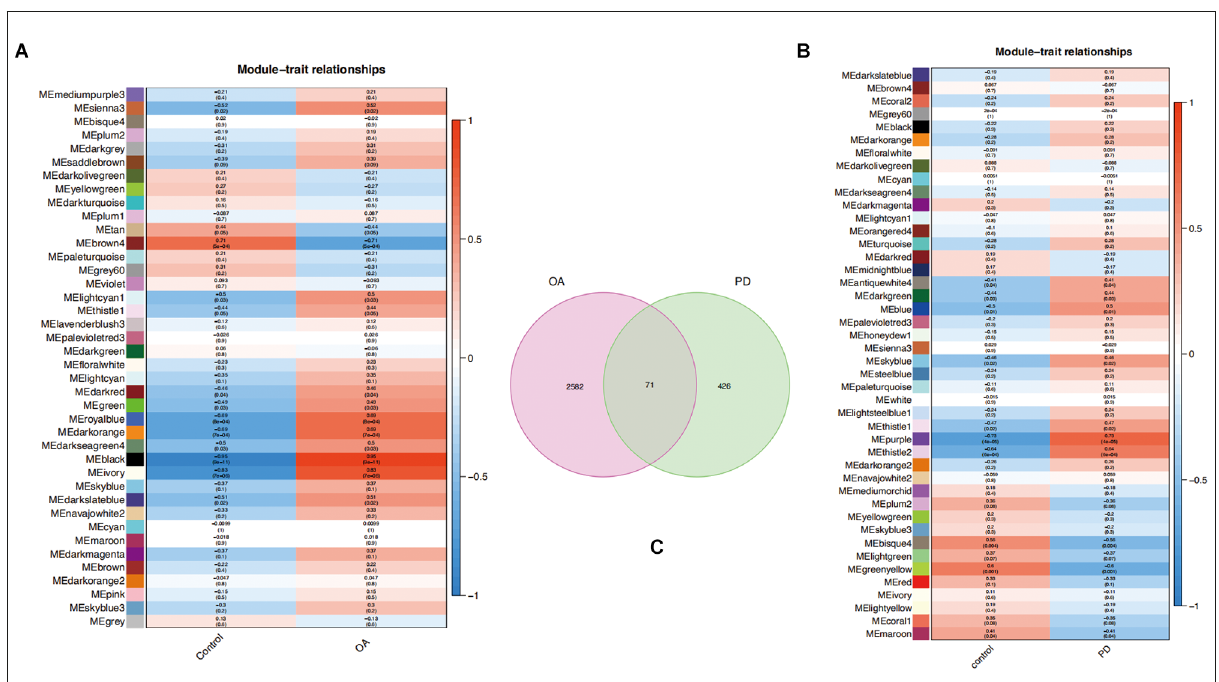
FIGURE4 (A,B) Each module eigengene (ME) was represented by a row in the heatmaps, and each clinical trait was shown in the columns. (C) Venn diagram of 71 common genes in the osteoarthritis (OA) and Parkinson’s disease (PD) datasets.